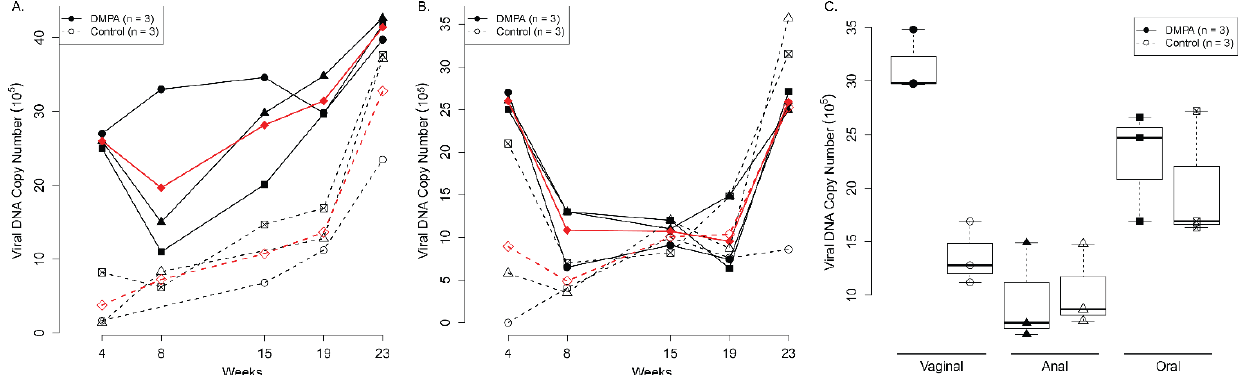
Figure 1. Increased viral load was detected in the lower genital tract ( A ) and anal tract ( B ) of Depo medroxyprogesterone (DMPA) treated athymic nude mice. Female athymic Hsd:Nu Mice with equivalent weight were distributed into two groups (n = 3) treated with DMPA (diestrus-like) or cloprostenol/progesterone (control, estrus-like stage) three days before viral infection at vaginal and anal tracts. Viral DNA was detected by collecting lavage samples from the vaginal tract, the anal tract, and the oral cavity followed by qPCR analysis at different time points post infection. Significantly higher viral DNA copies were found at the vaginal and anal site at earlier time points post